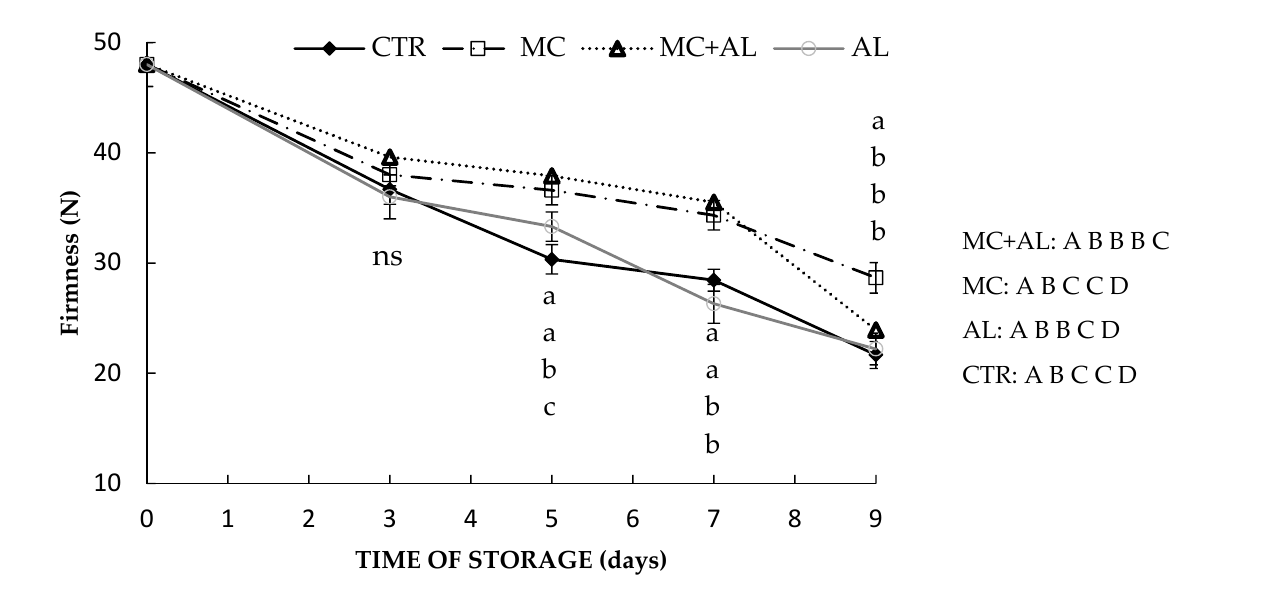
Figure 2. Firmness of fruit slices of Actinidia deliciosa (Liang, Ferguson) coated with O. ficus-indica (OFI) mucilage (MC), or mucilage + A. arborescens (MC+AL) or A. arborescens (AL) not treated (CTR), just after being coated (0) and at 3, 5, 7, 9 days of storage at 5 °C. Different lowercase letters indicate significant differences between treatments at each sampling date. Different capital letters indicate significant differences between sampling date for the same treatment. Tukeys’ significant test was applied at p ≤ 0.05. Data are means ± S.E. (n = 3). After 3 d, weight loss was higher in untreated than in AL, MC, and MC+AL kiwifruit slices, while after the cutting of kiwifruit, no significant differences were observed between treatments (Figure 3).